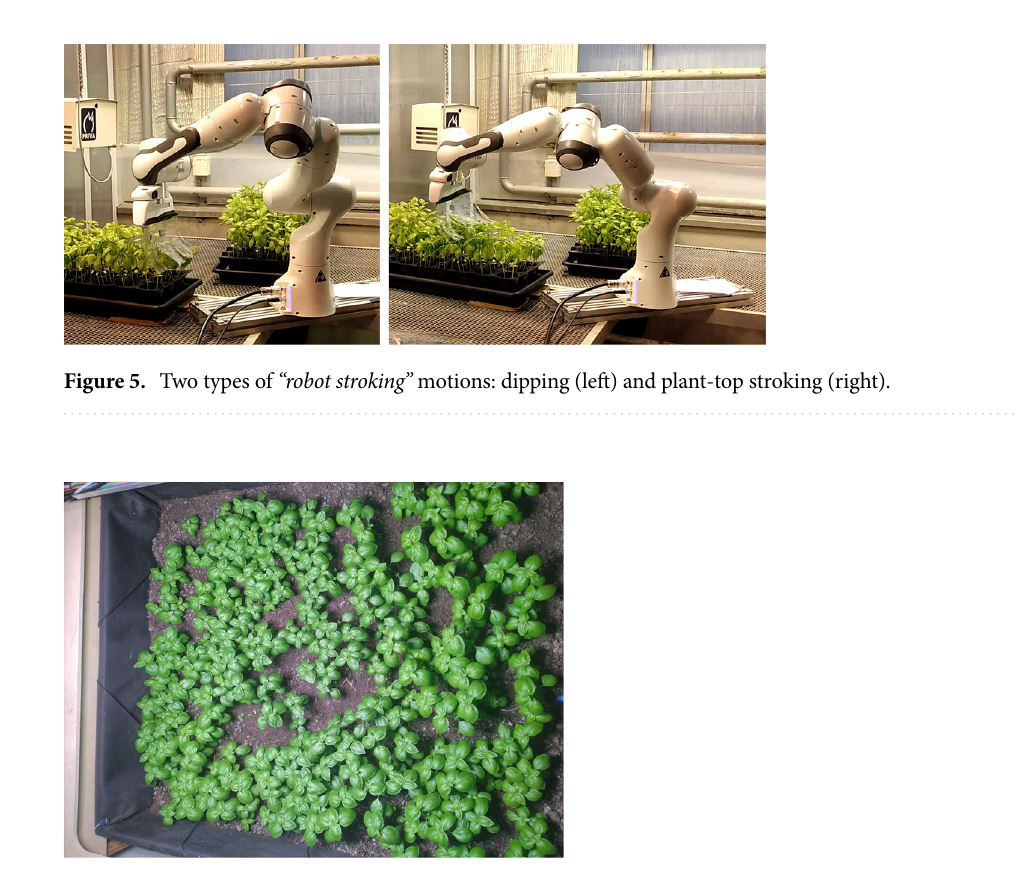
Figure 4. Treatment groups and trays prior to treatment starting. The first five rows of Tray1 and Tray2 are the 100 t/day and 2 t/day groups, respectively. The rest of the plants in the trays are Control1 and Control2 groups, respectively.